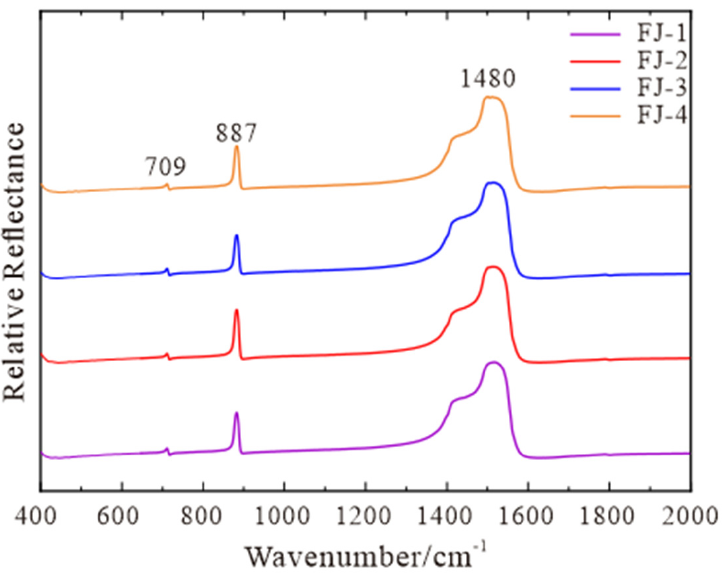
Figure 2. Fourier Transform Infrared Spectrum of FJ-1, FJ-2, FJ-3, and FJ-4.